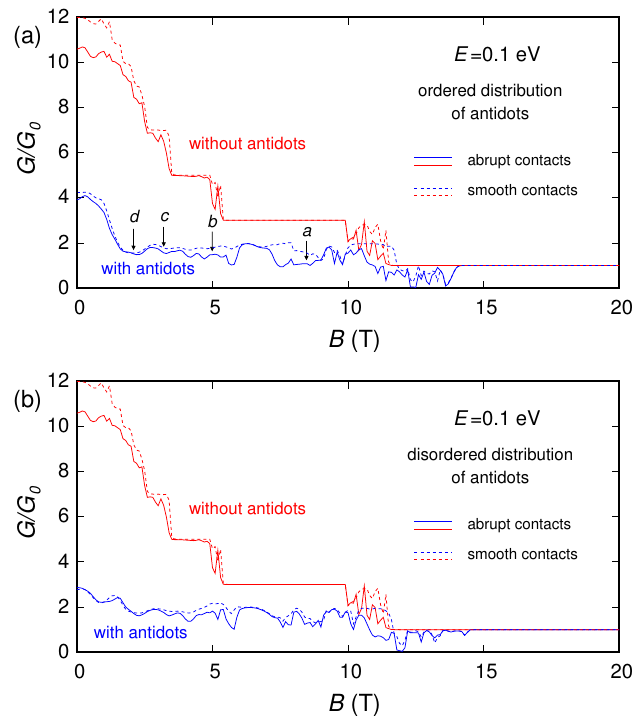
Figure 4. Normalized conductance of the graphene ribbon as a function of the orthogonal magnetic field, obtained for E = 0.1 eV in the presence of an ordered (panel ( a )) and a disordered (panel ( b )) distribution of antidots, compared with the conductance of the ribbon without antidots.